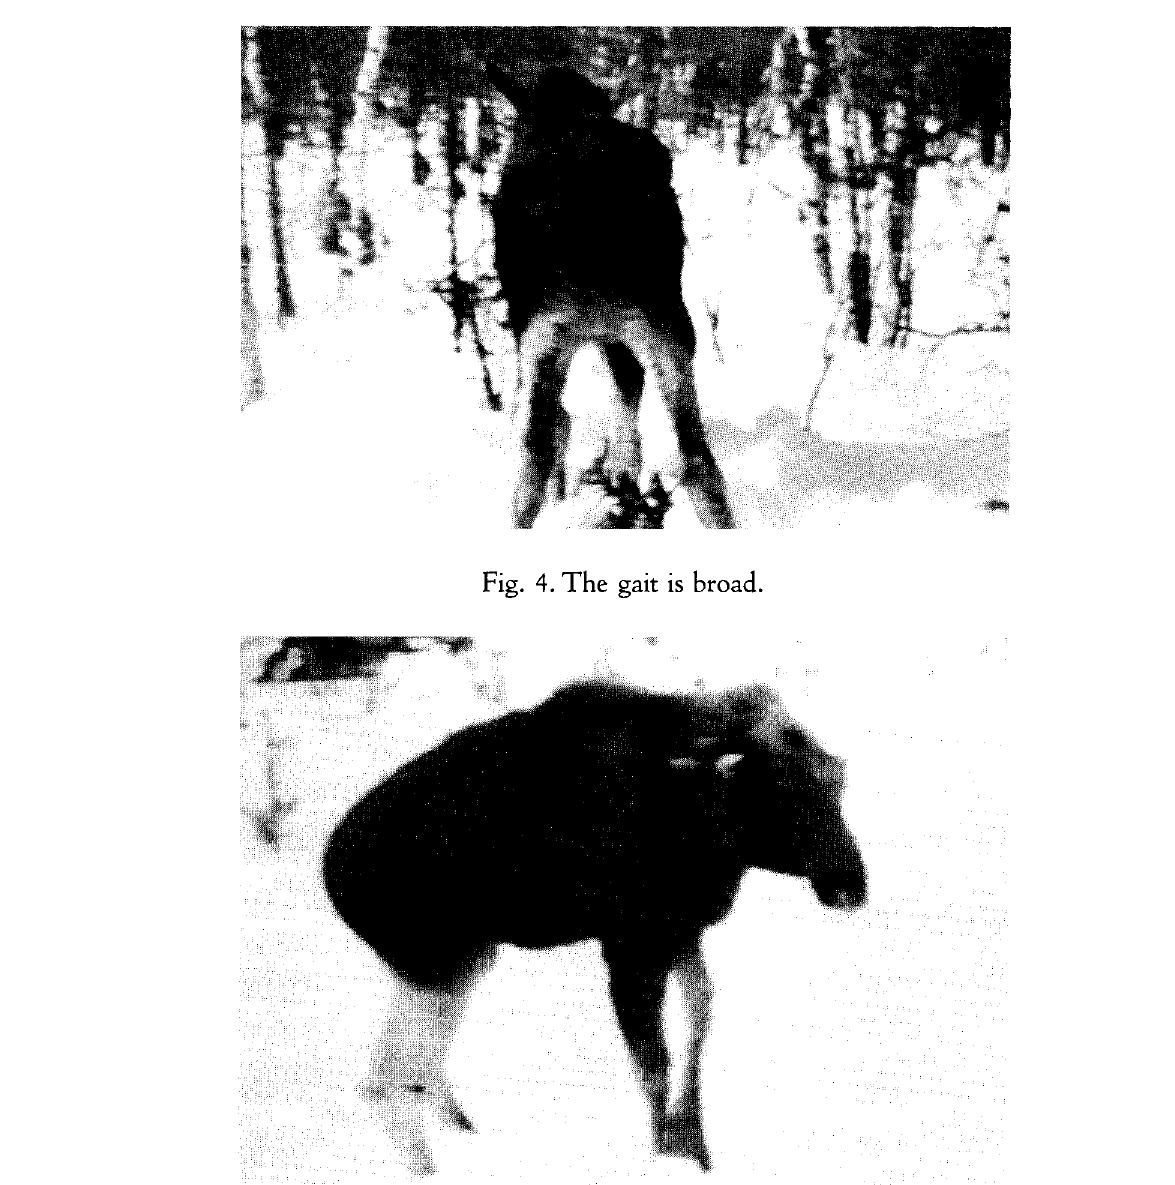
Fig. 5. Male moose calf with lame and atrophic left